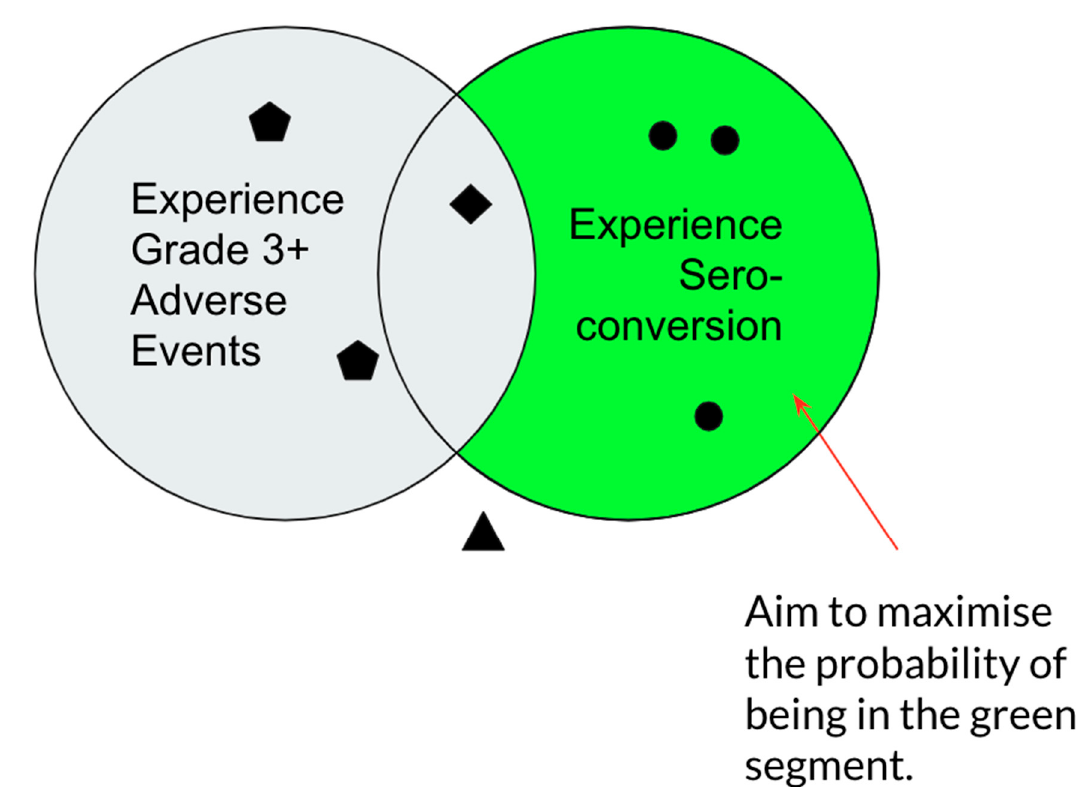
Figure 1. Venn diagram representation of possible outcomes of inoculation, where the left set includes individuals that experience grade 3+ adverse events and the right set includes individuals that experience seroconversion. We aimed to maximise the number of individuals that experience seroconversion and do not experience grade 3+ adverse events, represented in the green segment of the diagram. Black diamonds represent individuals that experience both outcomes, black pentagons represent individuals that experience grade 3+ adverse events with no seroconversion, and black triangles represent individuals that experience neither outcome.